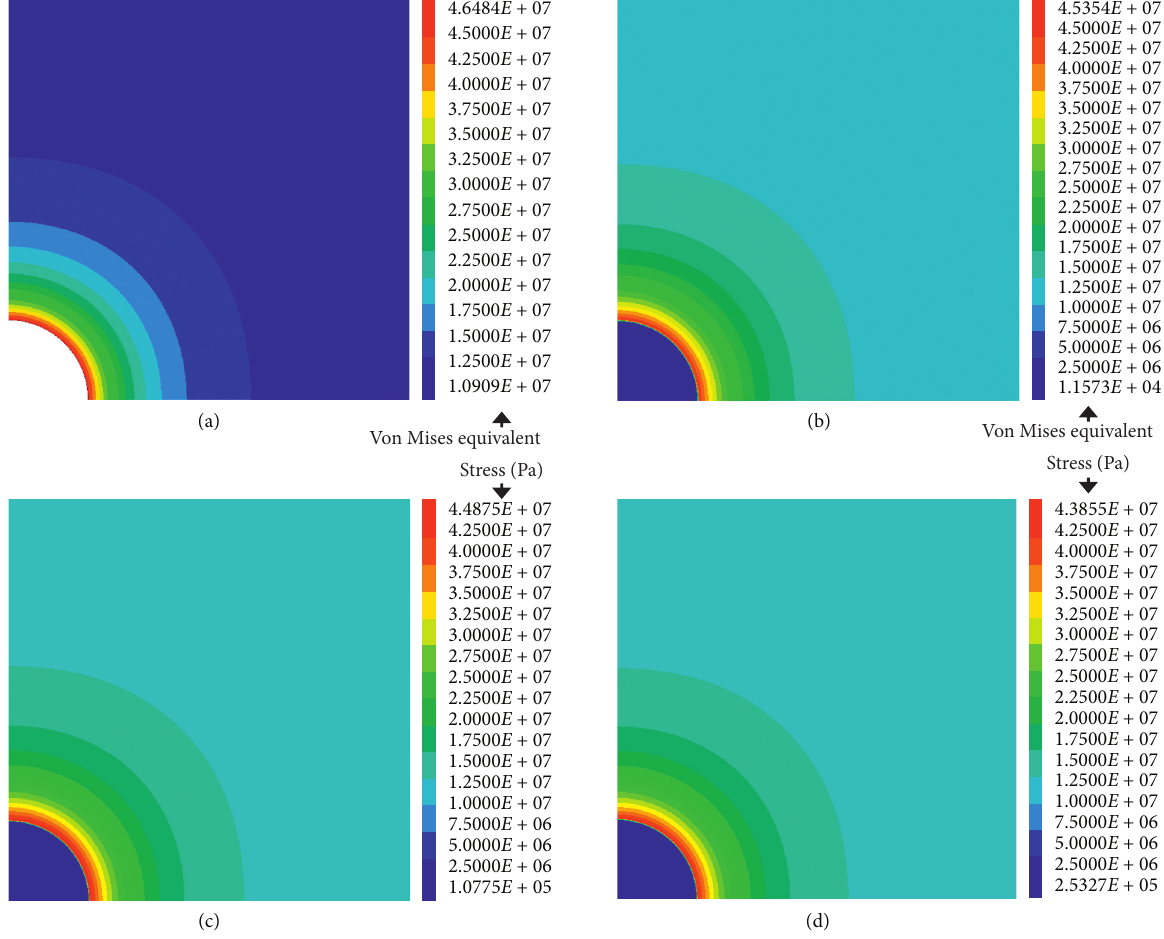
Figure 6: Contour of Mises equivalent stress of rock under the influence of different backfill-elastic modulus. (a) Nonbackfill; (b) ( E ) (c) ( E ) b � 300MPa; (d) ( E ) b � 900MPa.